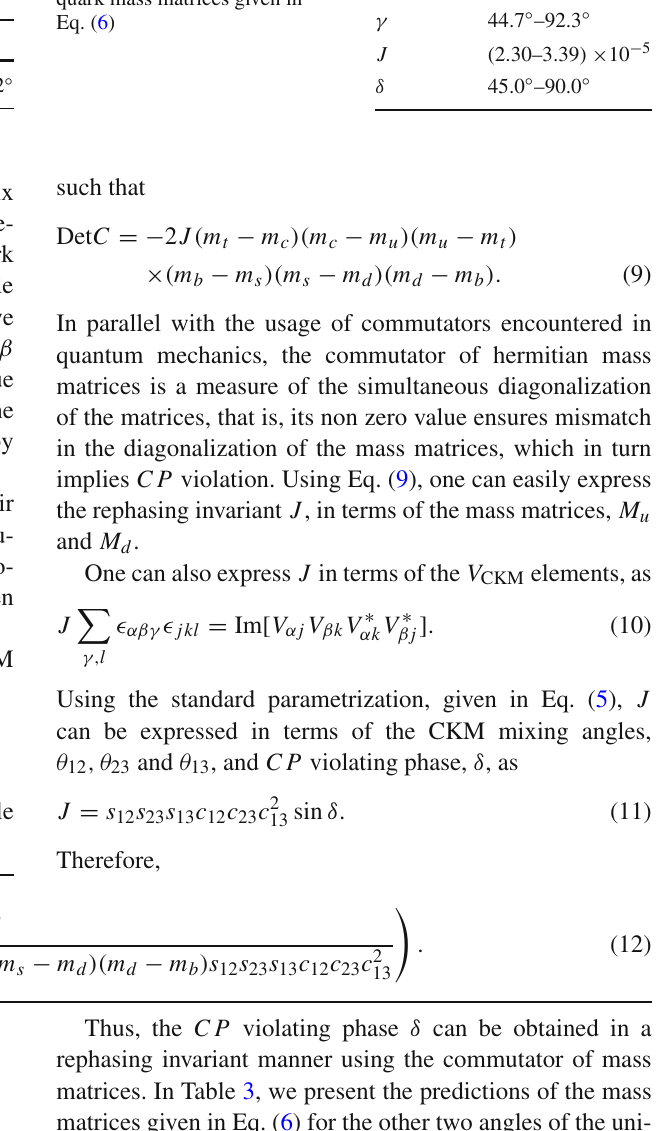
Table 2 Parameter ranges for the quark mass matrices given in Eq. (6) that reproduce the mixing parameters given in Table 1 D u (GeV) D d (GeV) φ 1